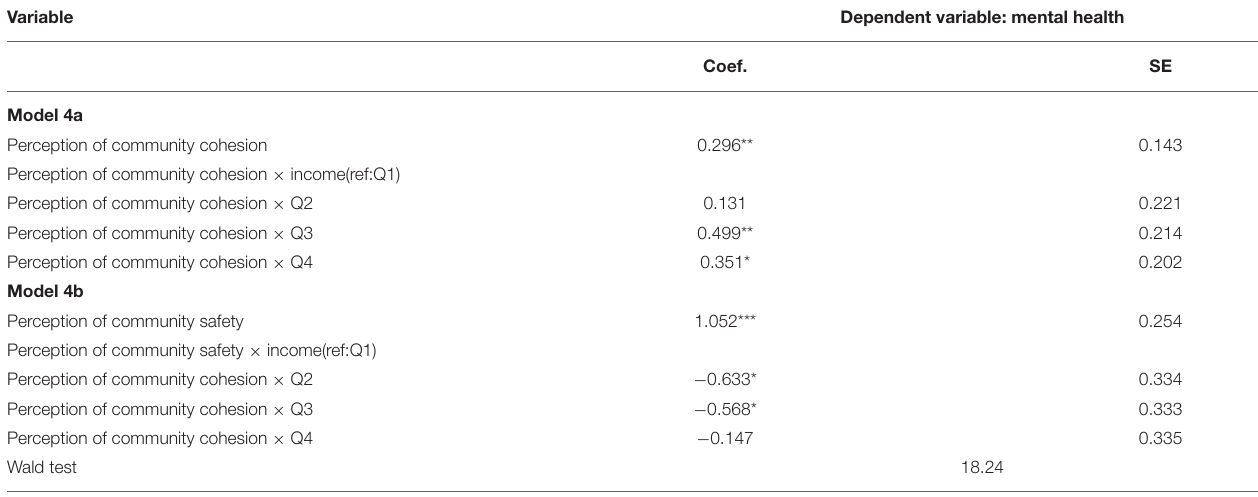
TABLE 7 | Relationship between the perception of community cohesion and safety and mental health: the moderating effect of income.